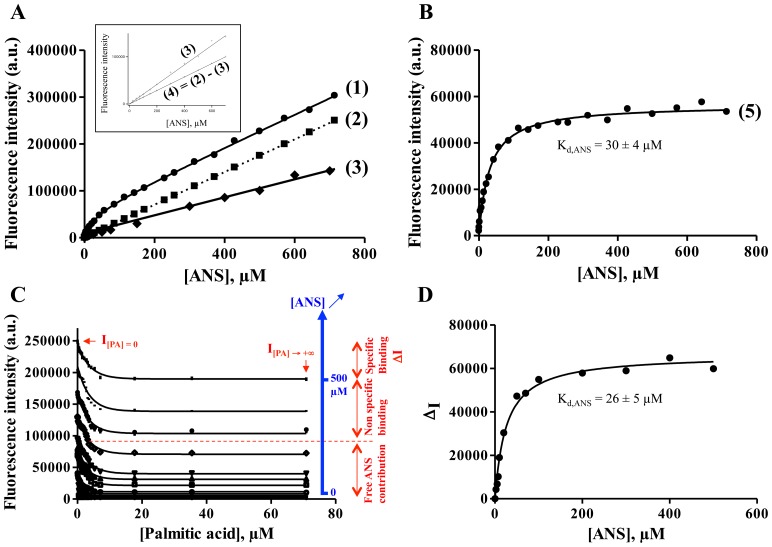
Binding of ANS to Cq-FABP.(A) The fluorescence emission intensity of ANS at 25°C (λexc = 350 nm) was plotted as a function of [ANS] in buffer C containing 5 µM Cq-FABP (curve 1) or in buffer C without protein (curve 3). The curve 1 represents the total intensity (Itotal) - after correction for the inner-filter effect - that accounts for both the “specific” and “non specific” signals (see text in the Results section). The calculated curve 2 represents a straight line having a slope equal to the one calculated in the linear part of curve 1 and that passes through the origin (0,0). This curve accounts for the “non specific” contributions in the ANS emission intensity: (i) the part of the emission fluorescence that originates from free ANS (Ifree) along the titration curve, corresponding to the experimental curve 3 (also reported in the inset), and (ii) the enhancement of the ANS fluorescence intensity due to the “non specific” binding (Inon spec), corresponding to the calculated curve 4 (inset). (B) Resulting binding isotherm (curve 5) after removing the different “non specific” contributions from the overall binding curve: Ispec = Itotal - Ifree - Inon spec or curve 5 = curve 1–curve 2 = curve 1−(curve 3+curve 4). The calculated Kd (30 µM) is related to the specific binding of ANS to the fatty acid binding site. (C) The fluorescence emission intensity of ANS (Itotal) was plotted against [PA] (after correction for the inner filter effect). Several ANS concentrations were tested (from 0 to 500 µM (blue arrow): 0, 2.5, 5, 7.5, 10, 20, 50, 70, 100, 200, 300, 400, 500 µM) with 5 µM Cq-FABP. The dashed line in red represents the fluorescence intensity level, as determined experimentally, accounting for free ANS under condition of [ANS] = 500 µM. ΔI corresponds to the displacement amplitude (ΔI = I[PA] = 0−I[PA]->+∞), related to the “specific binding” of ANS (an example corresponding to 500 µM ANS is shown in red color). ΔI was plotted against [ANS] (panel (D)).